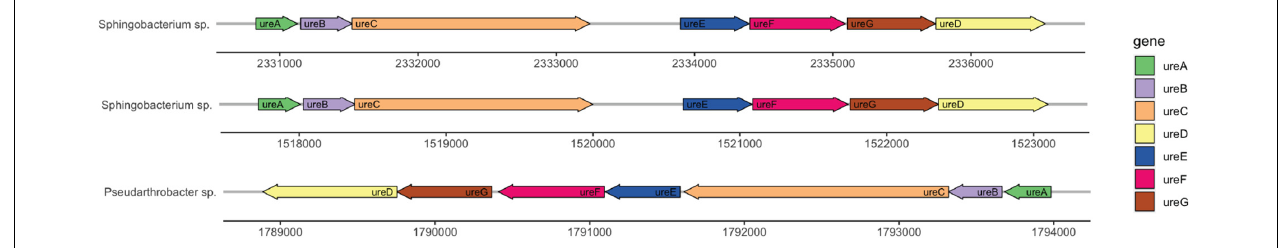
FIGURE 6 | Urease gene clusters of cave bacterial isolates show similar genetic features. Sphingobacterium sp. PCS056 encodes two copies of the urease pathway genes ( ureABCDEFG ), with similar orientation and gene sizes, and a hypothetical gene in between ureC and ureD , represented as a gap. Pseudarthrobacter sp. SSS035 also presents a continuous cluster in a reverse orientation.